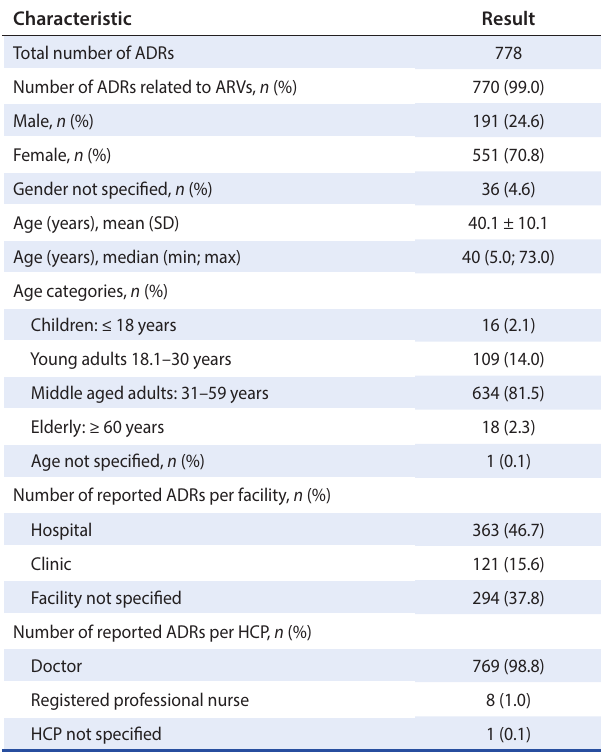
Notes: ADRs: adverse drug reactions; ARVs: antiretrovirals; HCP: healthcare professional.